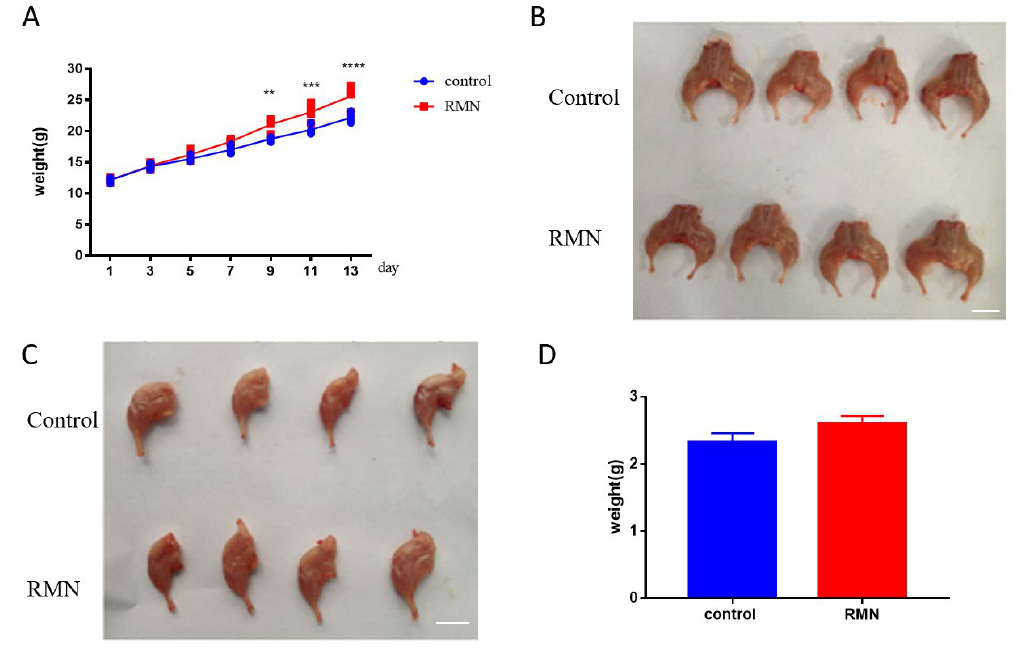
ff ect of RMN injection on mouse weight. ( A , B ). The total weight significantly increased Figure 3. Effect of RMN injection on mouse weight. ( A, B ). The total weight significantly increased 164 Figure 3. E after the mice were injected four times, and the dissected morphology of the hind leg showed that mice injected with 50 µ g RMN in their hind legs presented obviously bigger volume compared to the mice in the PBS group. Scale bar: 1 cm. ( C , D ). One side of the hind leg had a bigger diameter compared to the control and there was an increase tendency of weight in treatment with RMN compared to